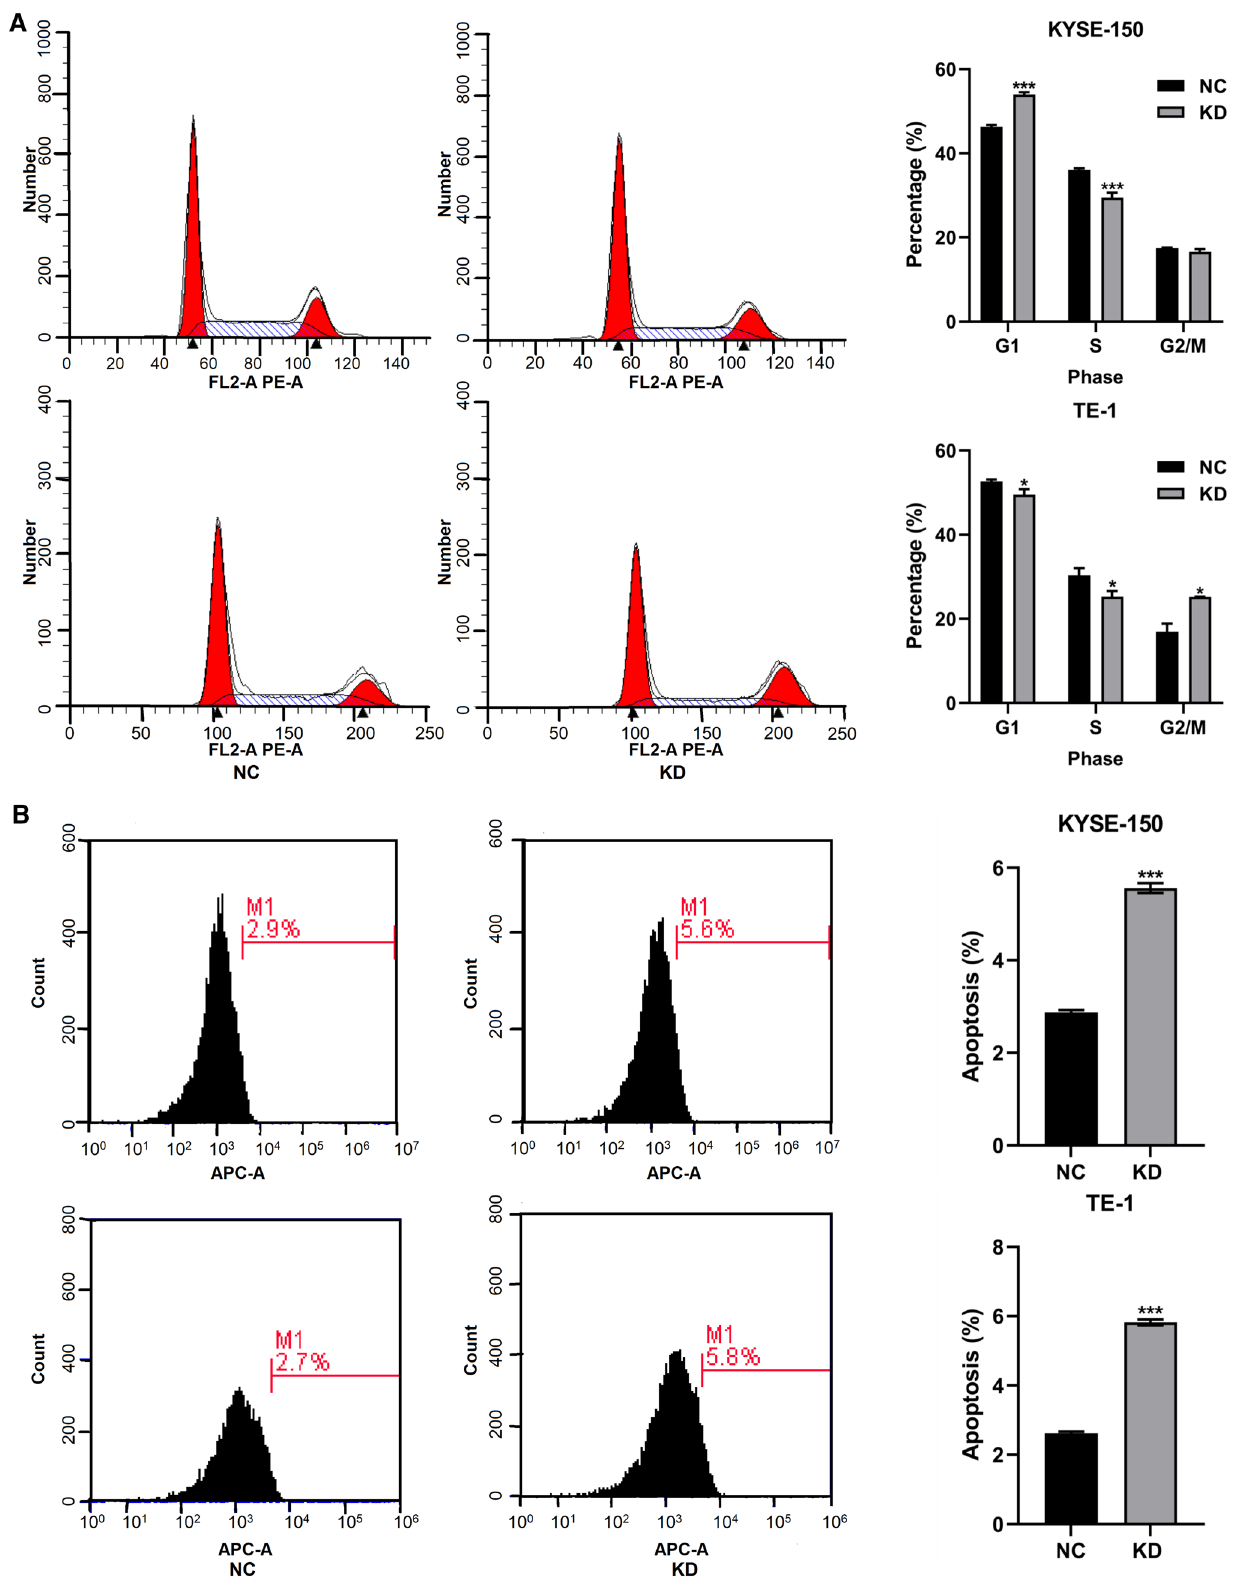
Fig. 5 Knockdown of RAD51AP1 induced cell cycle arrest and cell apoptosis in ESCC. A Flow cytometry analysis showed that knockdown of RAD51AP1 led to cell cycle arrest in KYSE150 and TE1 cells. B Flow cytometry analysis showed that knockdown of RAD51AP1 markedly pro- moted cell apoptosis in KYSE150 and TE1 cells. ESCC, esophageal squamous cell carcinoma. * p < 0.05; ** p < 0.01, *** p <